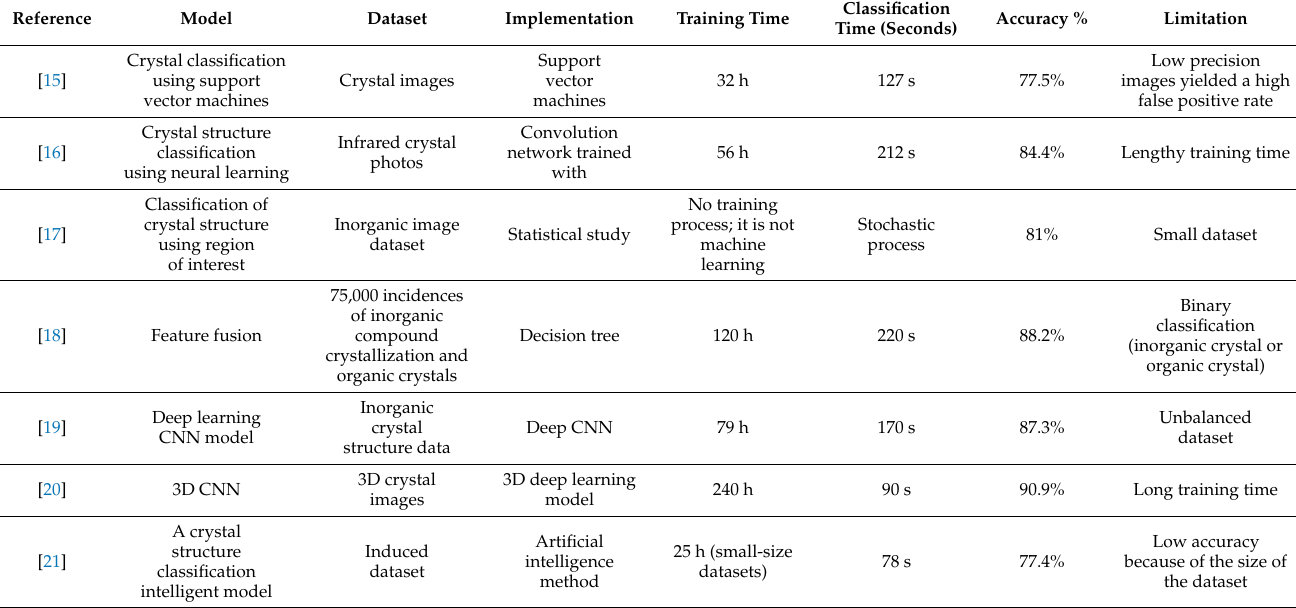
Table 1. Summary of different machine learning and deep learning models to detect the crystal structures in different